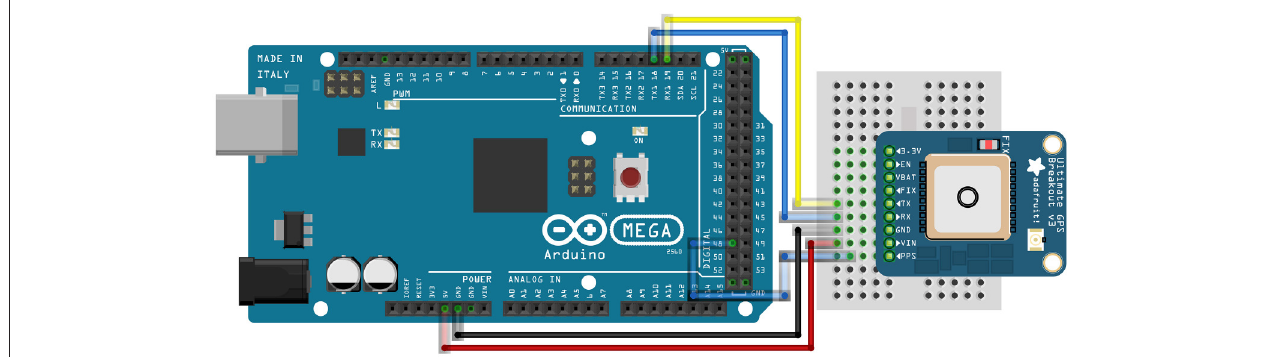
FIGURE 8 | Experimental setup for long-term operational stability of GPS module.